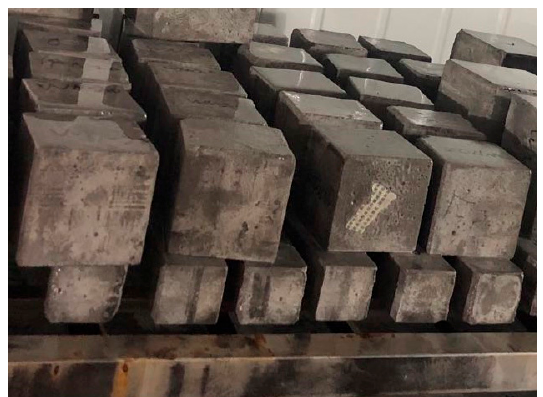
Figure 14. Specimens in the curing